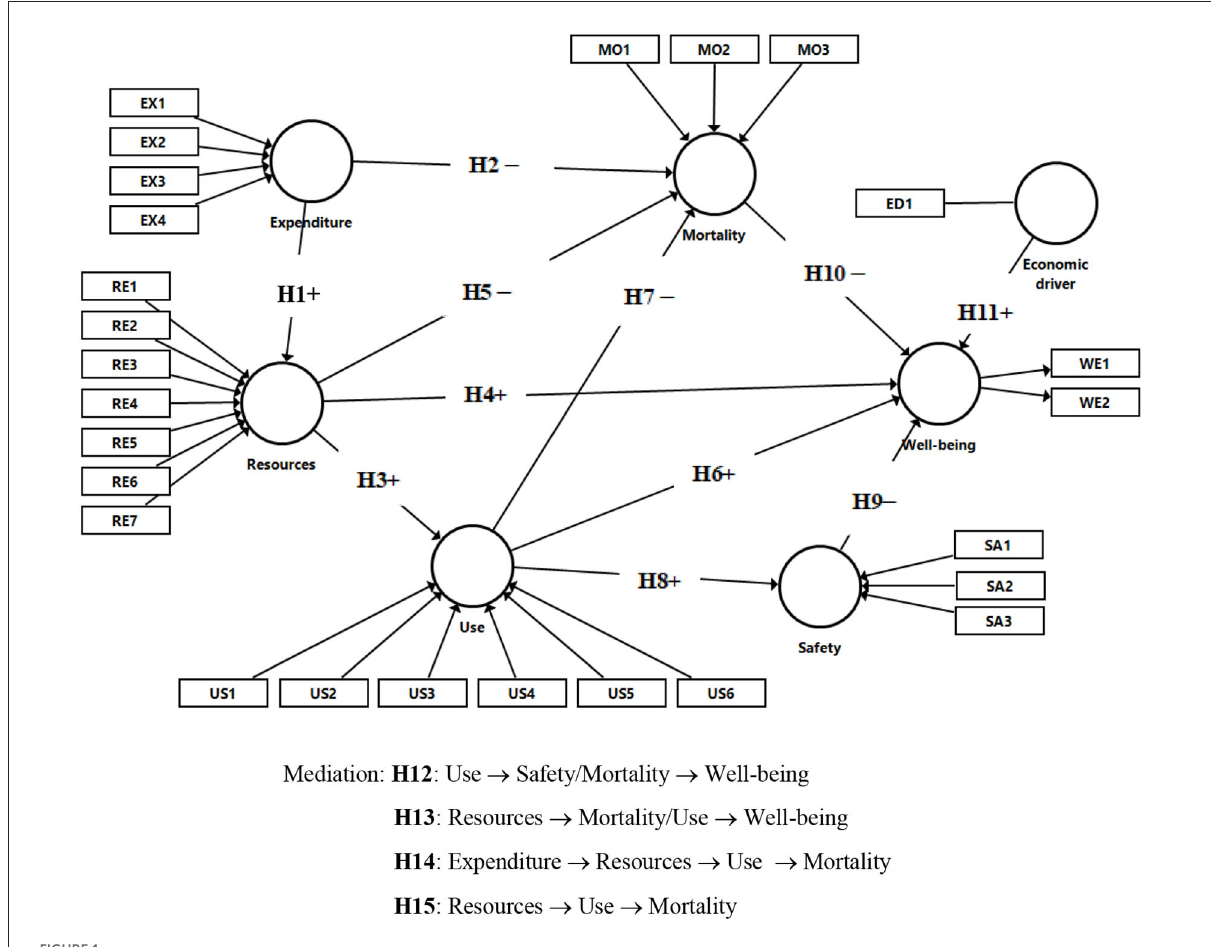
FIGURE1 Research